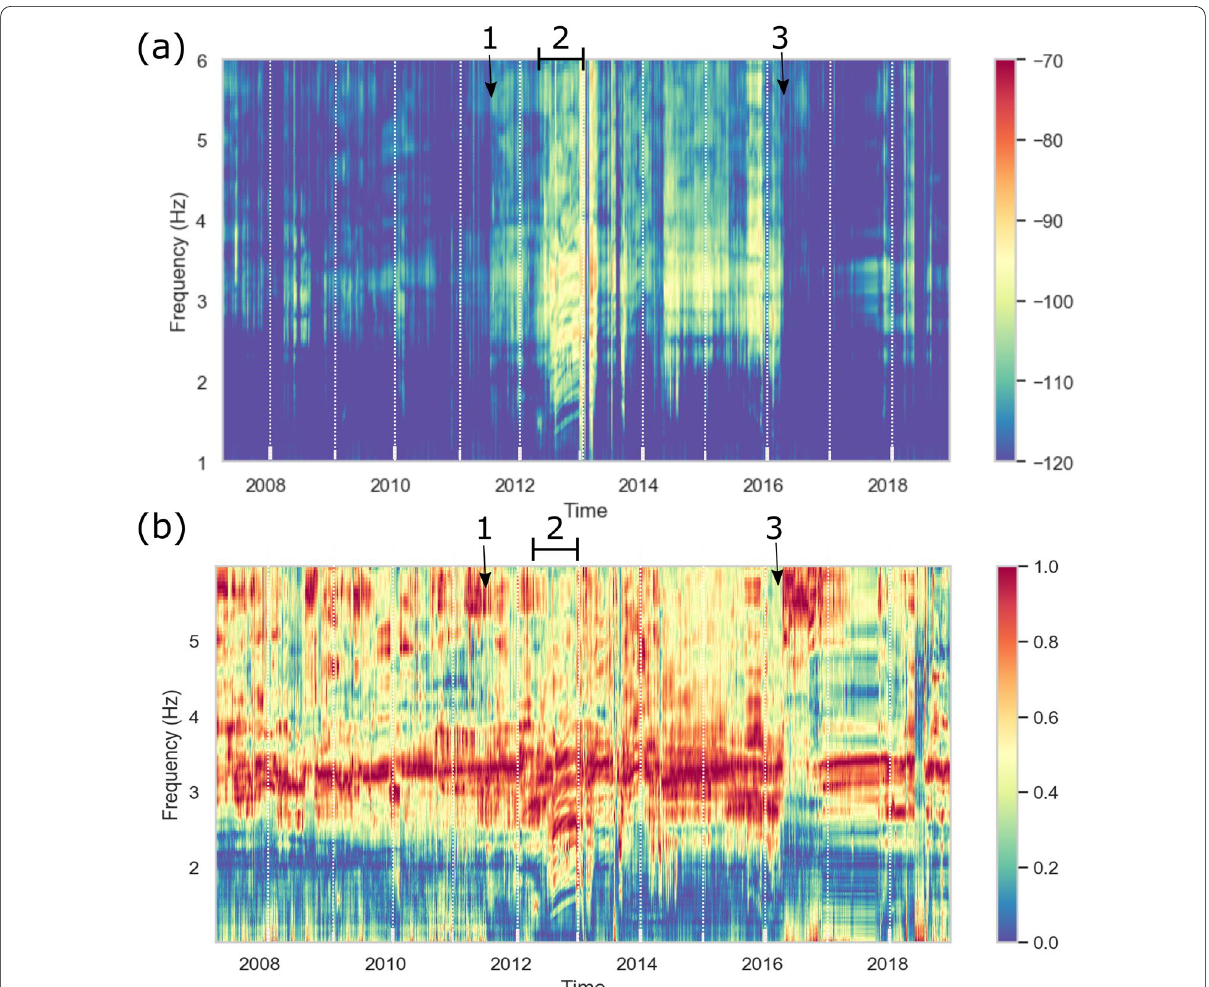
Fig. 2 PSD along time at WIZ. Years are marked by white lines on 1st January of each year. ( a ) Non-normalized ( b ) divided by the range between minimum and maximum values in each time window. Key periods are (1) 2011 earthquake swarm, (2) dome extrusion, and (3) April 2016 eruption. Each tick on the x -axis corresponds to 1 January of each